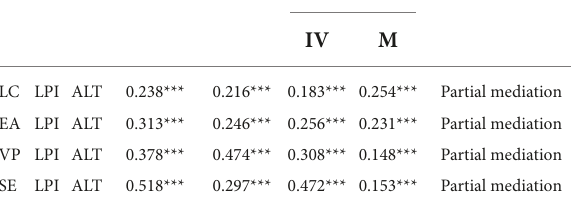
TABLE 7 Mediating effect of the low-carbon production